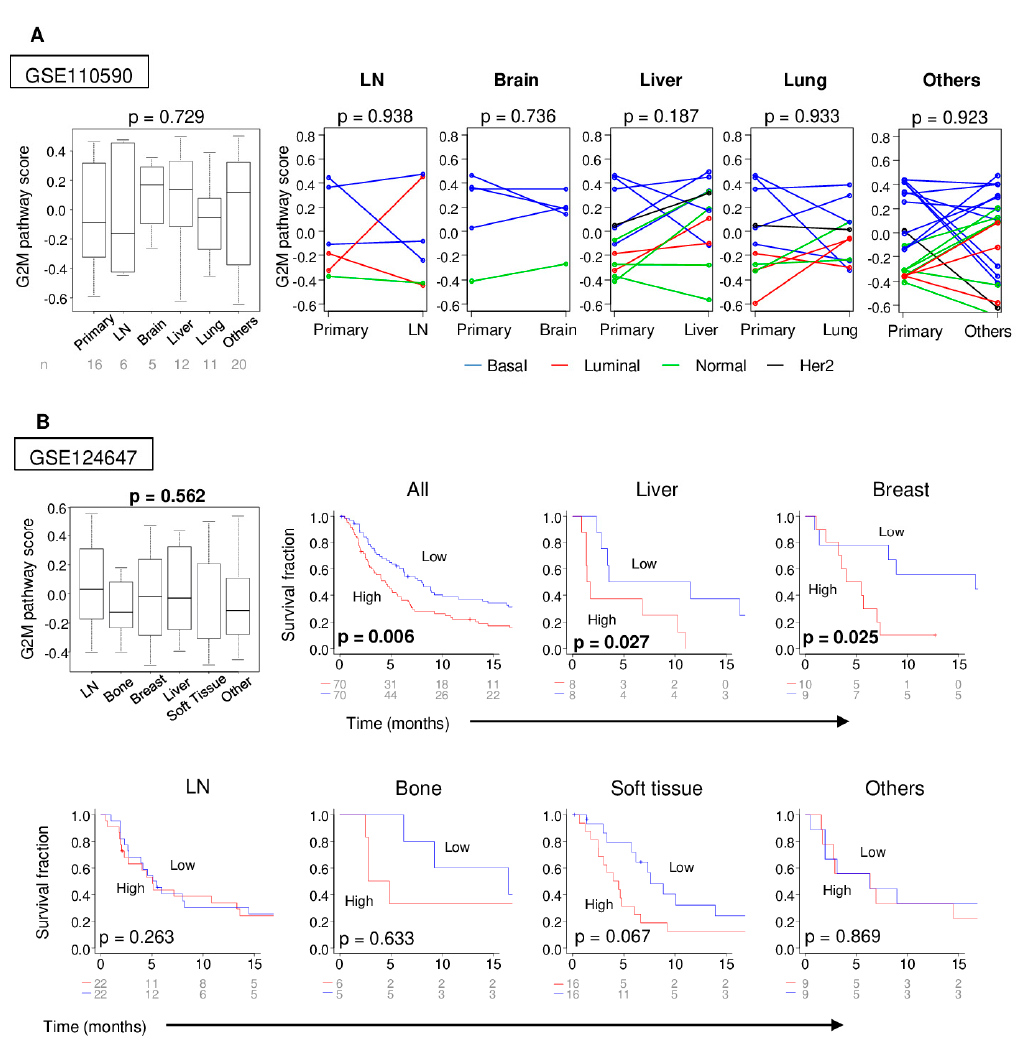
Figure 4. ( A ) Boxplots of the G2M pathway score of primary and each metastatic tumor, and matched pair comparison of G2M pathway scores between the primary and each metastatic tumor, including lymph node, brain, liver, lung and others in GSE110590 cohort. The PAM50 subtypes of cancer are indicated. ( B ) Boxplots of G2M pathway score of primary and each metastatic tumor, and Kaplan–Meier plots with logrank test p -values; progression-free survival ( PFS ) between the high- and low-G2M pathway score groups within different metastatic sites in the GSE124647 cohort. The median value of the G2M pathway score was used to divide patients into low and high groups.